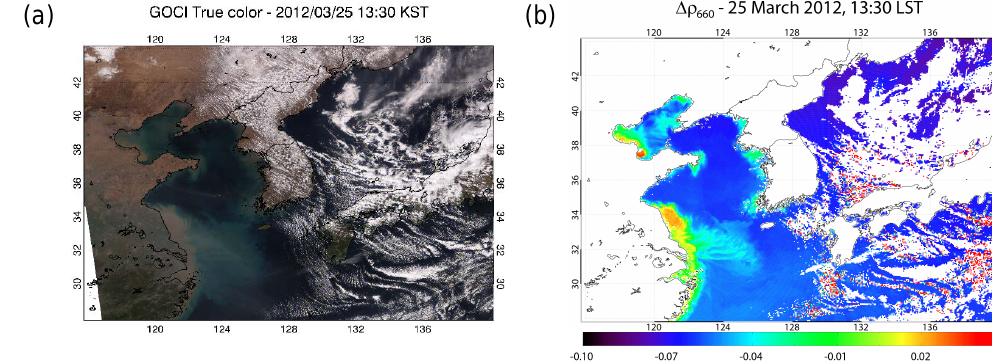
Figure 5. 25 March 2012, 13:30LST (a) true color image and (b) (cid:49)ρ 660 . Table 3. The number of AERONET inversion data, and considering AE between 440 and 870nm, FMF at 550nm, and SSA at 440nm for the 26 aerosol models. The minimum and maximum values are shown because of AOD dependence. H, M, and N denote highly absorbing, moderately absorbing, and non-absorbing models,